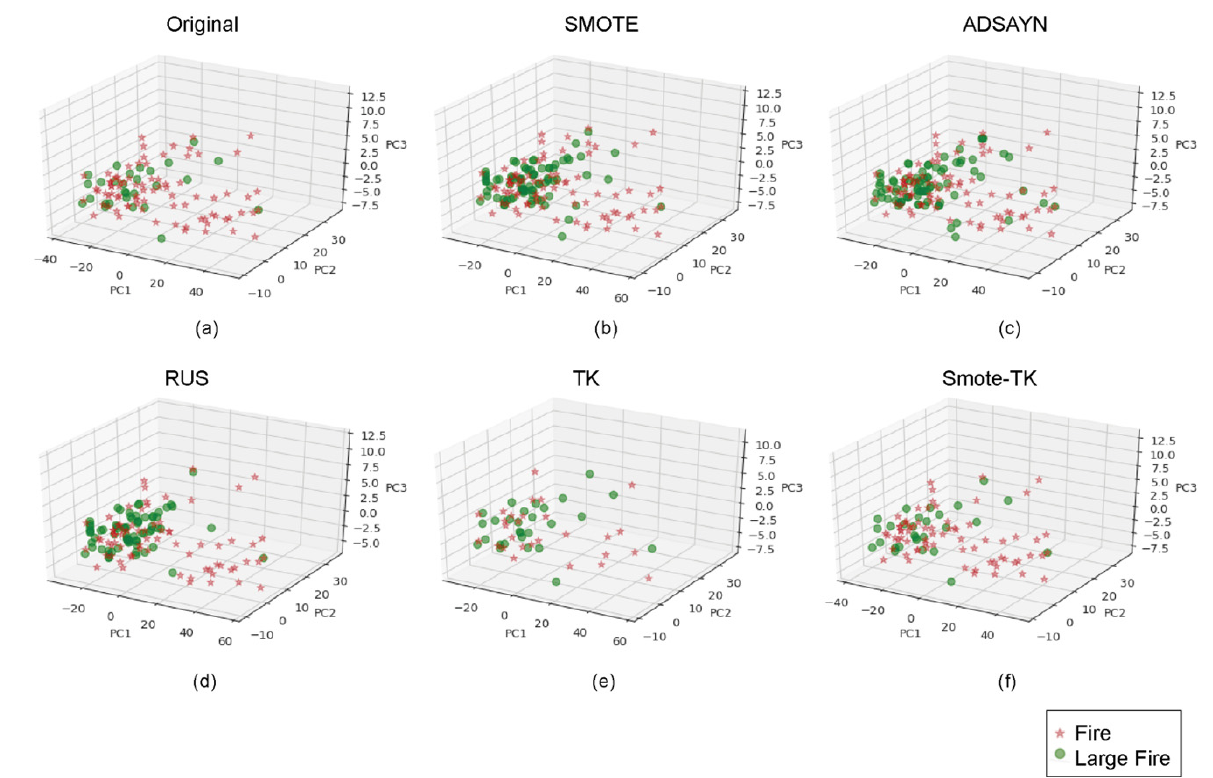
Figure 5. Three-dimensional PCA results per original and synthetic datasets: ( a ) Original data, ( b ) SMOTE, ( c ) ADASYN, ( d ) RUS, ( e ) TK and ( f ) Smote-TK.